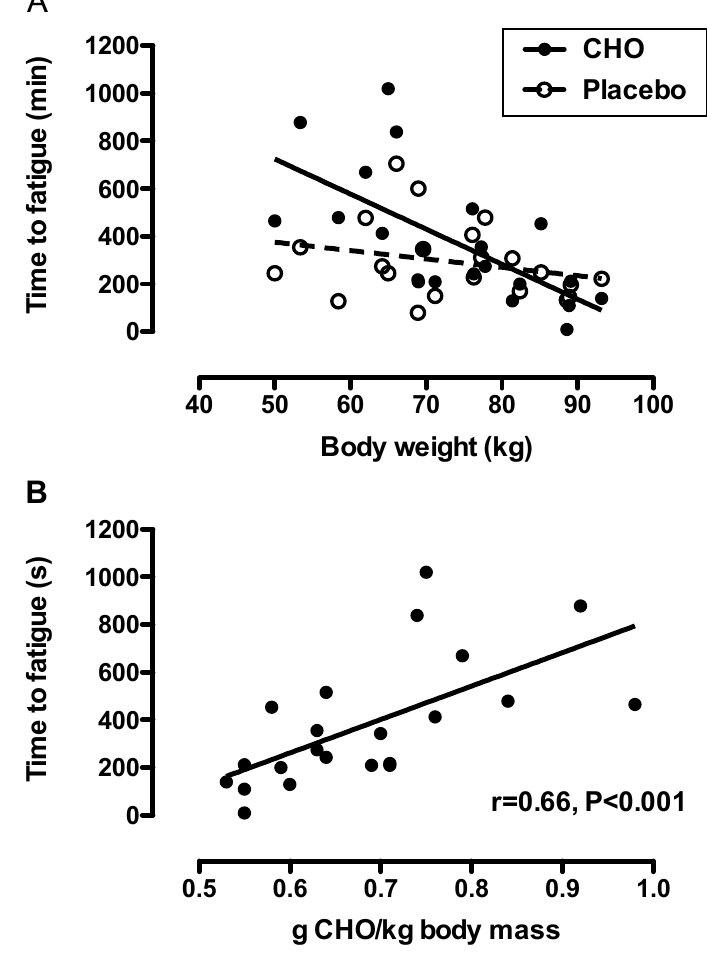
Figure 4. ( A ) The influence of body mass on time to fatigue during the simulated soccer match while ingesting the placebo (0% CHO) or the 7% CHO solutions ( p = 0.023 for drinks × body mass interaction). ( B ) The relationship between CHO ingestion (g/kg body mass) and time to fatigue during the simulated soccer match.